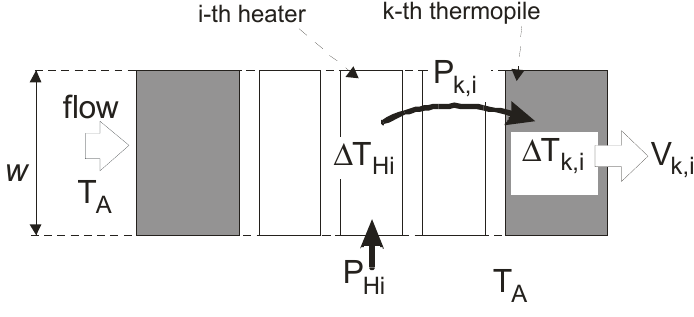
Figure 3. Visual representation of the symbols used to define the lumped element